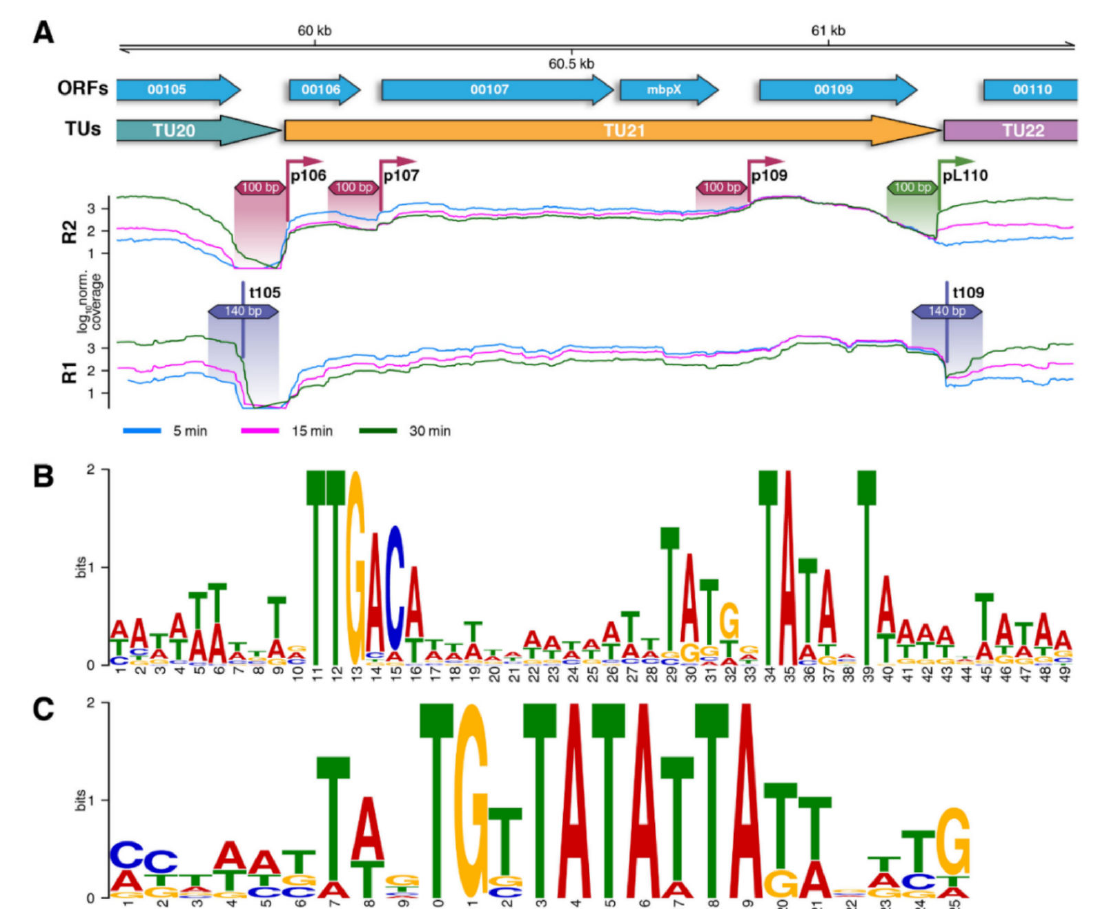
Figure 2. Identification of bacteriophage regulatory elements. ( A ) Search scheme for promoters and transcription terminators. Reverse (R2) and direct (R1) reads were used to predict for TSSs and TTSs, respectively. The color of genes and transcription units corresponds to that in Figure 3; ( B ) consensus sequence logo for early promoters; ( C ) consensus sequence logo for late